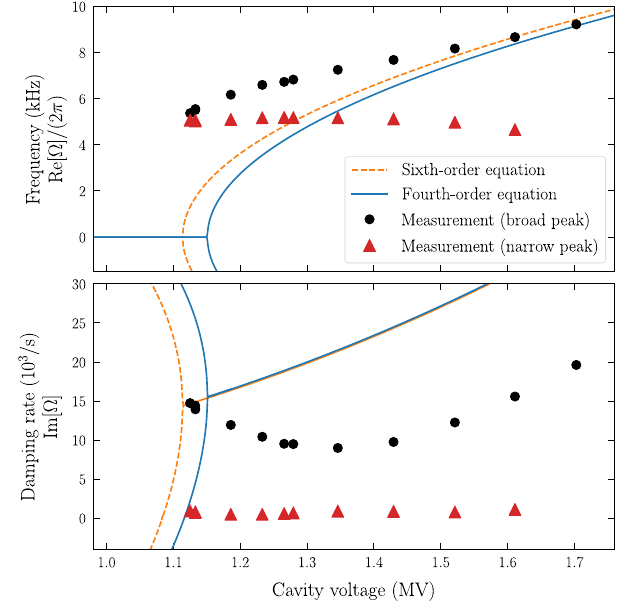
FIG. 19. Comparison between the theoretical solutions and measurement of the complex frequency as functions of the cavity voltage. The beam current is fixed at 350 mA. The dashed lines show the numerical solutions of the sixth-order characteristic Eq. (B1), whereas the solid lines indicate the solutions of the fourth-order Eq. (1). The measured data are the same as those shown in Fig.